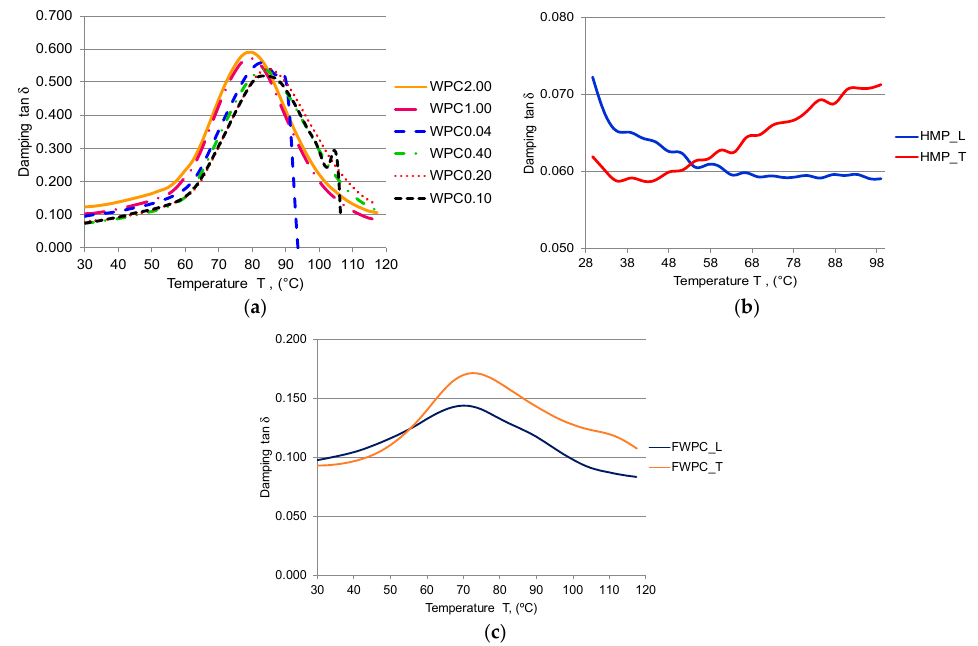
Figure 13. Variation of the damping tan δ with temperature: ( a ) WPC samples; ( b ) HMP samples; ( c ) FWCP samples.